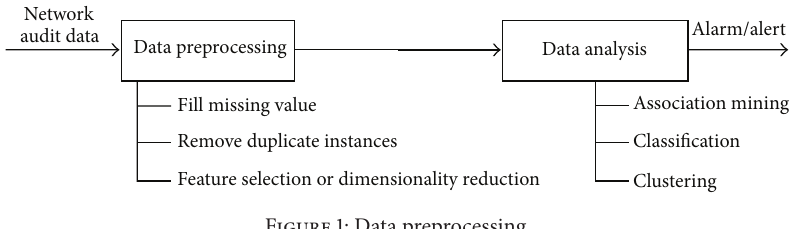
Figure 1: Data preprocessing.